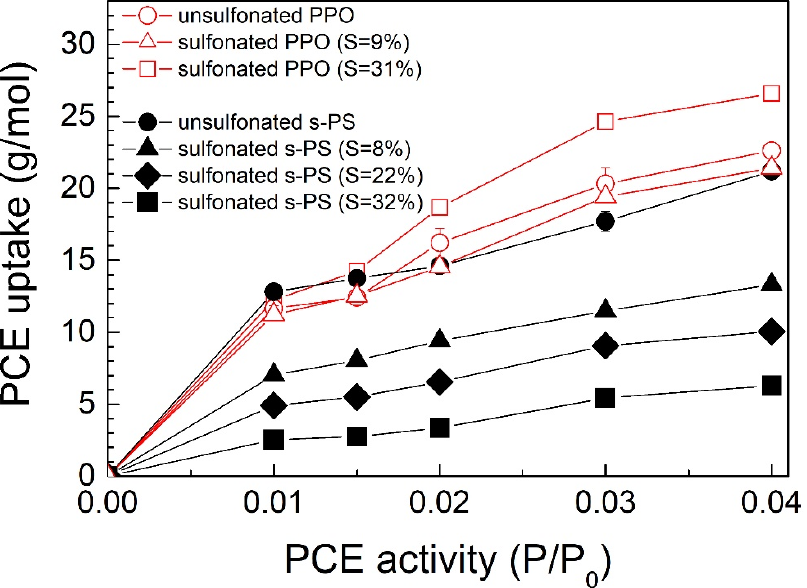
Figure 7. PCE vapour uptake at 35 °C for P/P 0 up to 0.04 in unsulfonated and sulfonated s-PS (black, closed symbols) and PPO aerogels (red, open symbols) with different degrees of sulfonation.